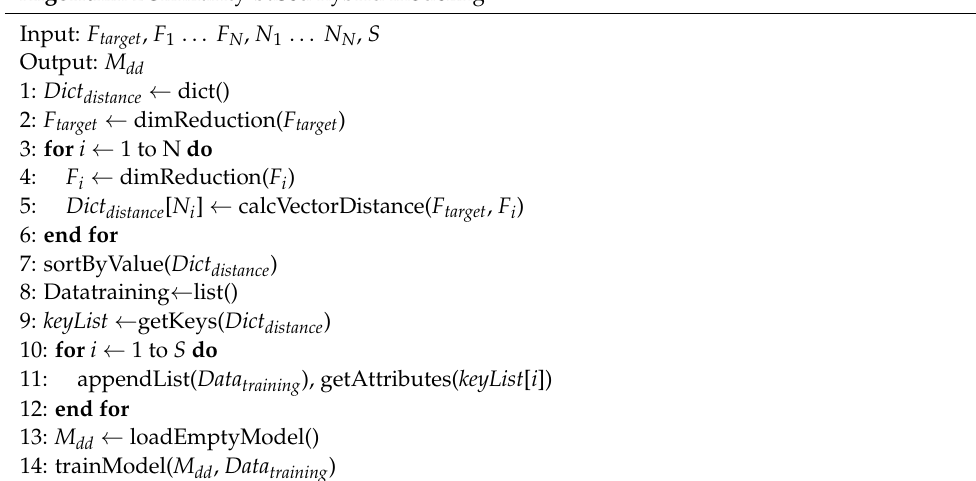
Algorithm 2 Similarity-based hybrid